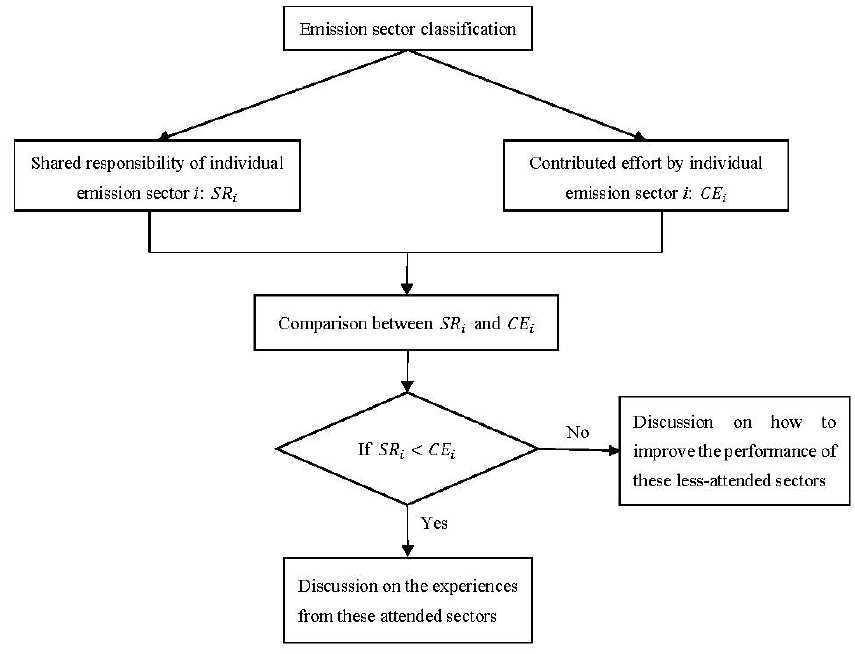
Figure 1. Research framework.